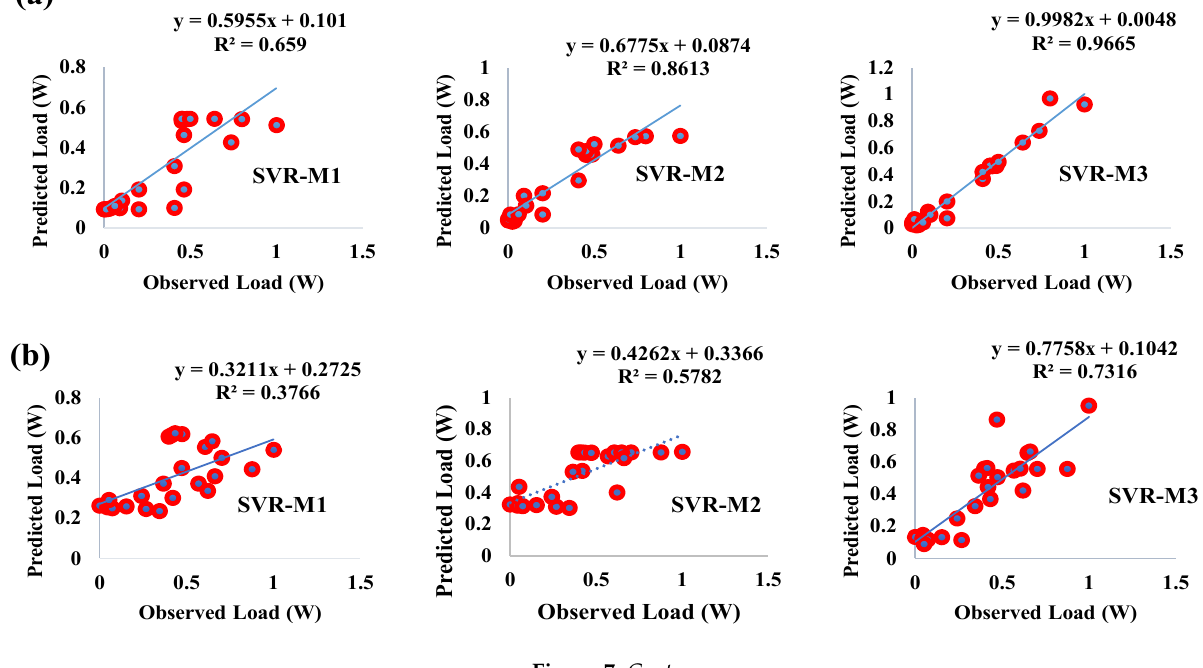
Table 1. Results of evaluation for traditional SVR models (Kano, Abuja, Niger, and